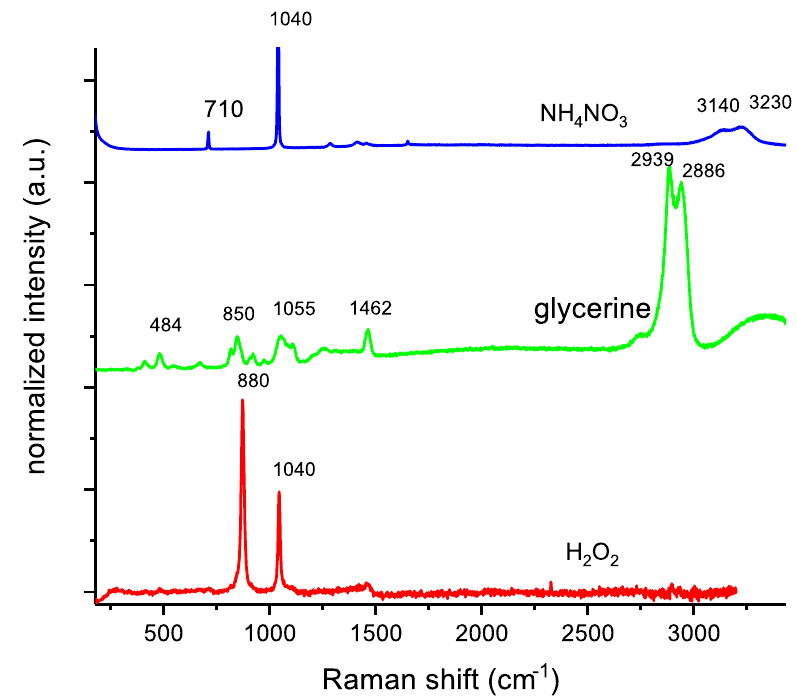
Figure 2. Raman spectra of OSM